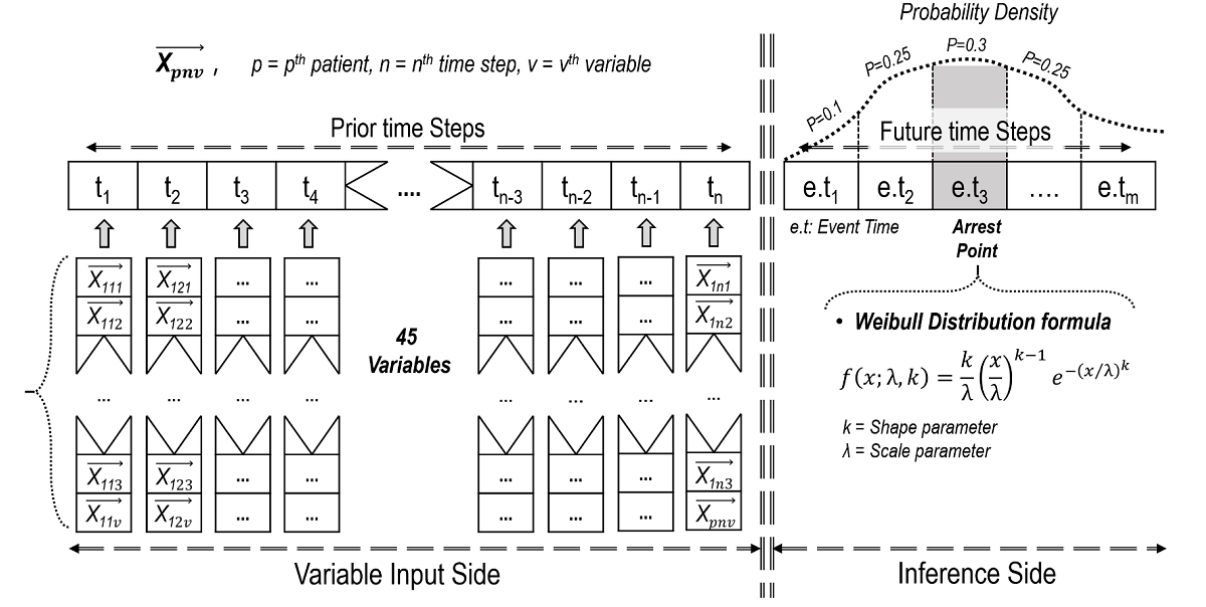
Figure 2. Character-level gated recurrent unit structure combined with the Weibull